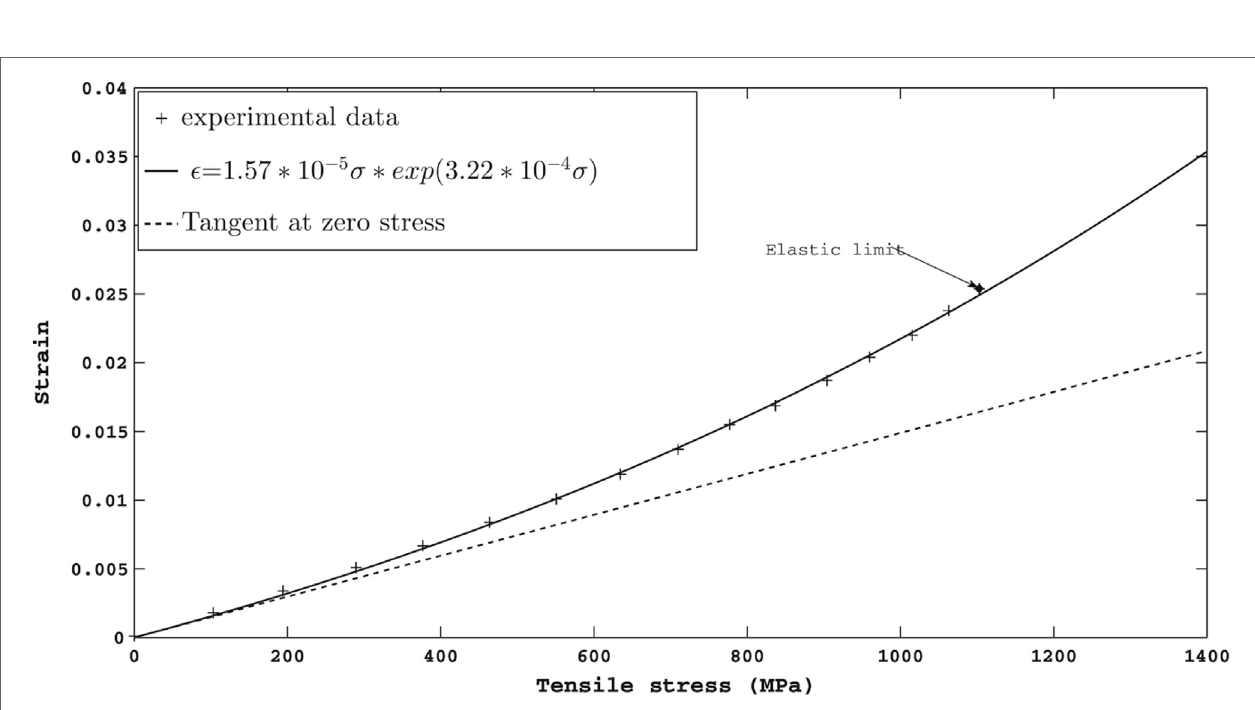
FigURe 7 | Non-linear relationship between the strain and stress in the small strain range for a gum metal alloy [figure is taken from the paper by Saito et al. (2003)] .